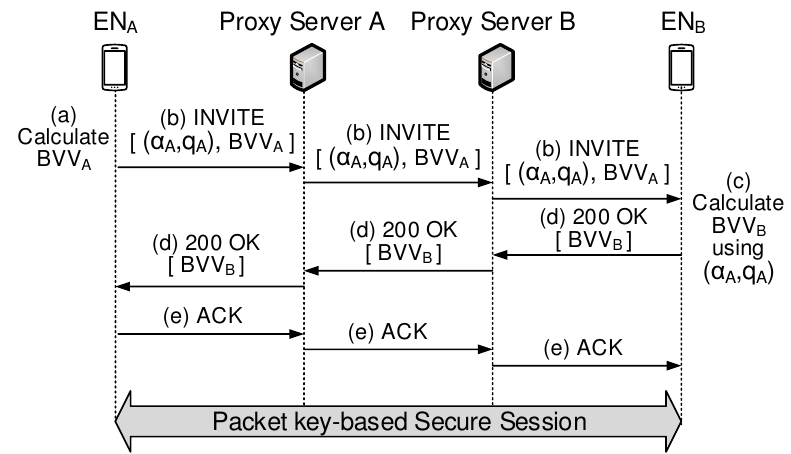
Figure 12. Secure Session Initiation Protocol (SIP) model for the packet key-based encrypted data flow.